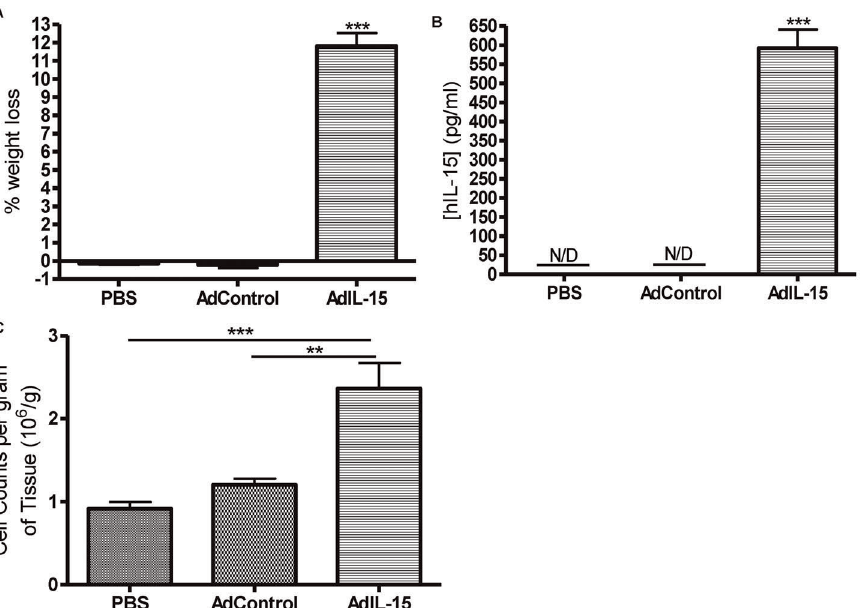
Figure 1. Acute interleukin-15 administration results in weight loss and increased cell number in visceral adipose tissue of B6 mice. ( A ) Bar graph shows percentage of weight loss in female B6 mice treated i.v. with either phosphate-buffered saline (PBS), an empty adenoviral construct not expressing IL-15 (Ad-Control), or IL-15 expressing adenoviral construct (AdIL-15). ( B ) Serum collected on day 8 was analyzed for IL-15 expression using a hIL-15 DuoSet ELISA kit. ( C ) The cells referred to are the number of cells in the stromal vascular fraction from digested adipose tissue in each group. The y-axis refers to the number of cells ( 6 10 6 ) counted from the stromal vascular fraction per gram of digested visceral gonadal adipose tissue shown in bar graph (n=5 per group). **P , 0.01, ***P ,